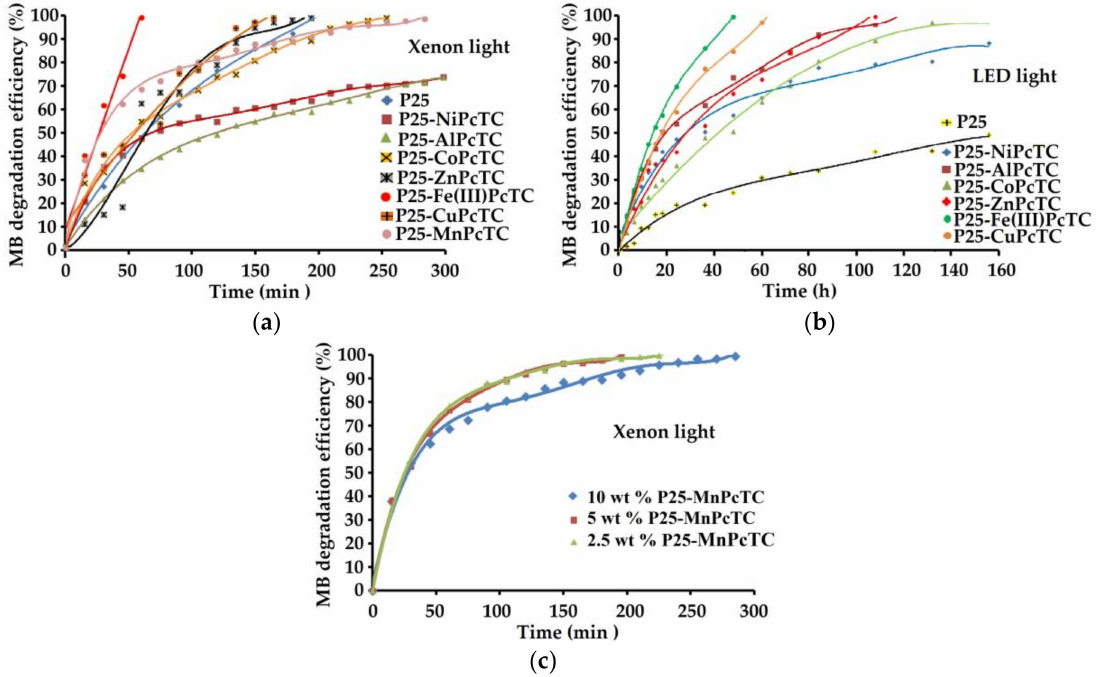
Figure 6. Methylene Blue (MB) degradation efficiency: ( a ) under Xenon light exposure; ( b ) under LED light exposure at a photocatalyst loading of 10 wt %; and ( c ) under Xenon light exposure as a function of photocatalyst